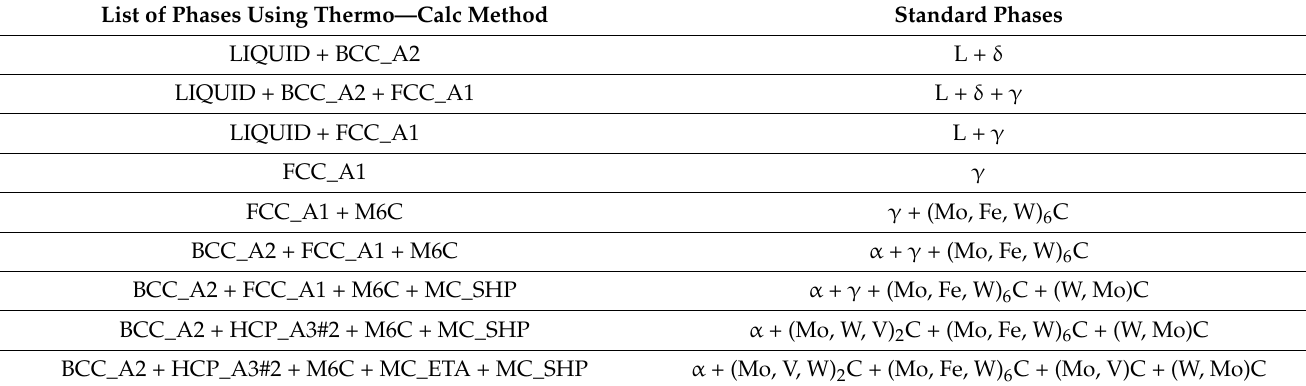
Table 2. List of the stable phases from the calculation of the phase diagram using the Thermo- Calc